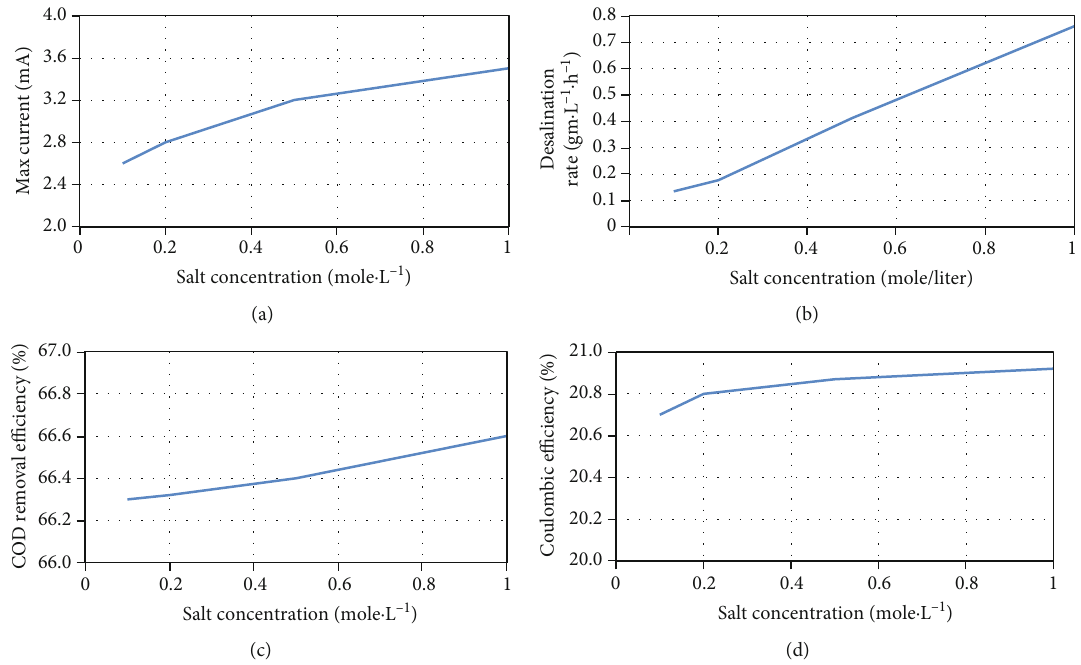
Figure 4: Model predictions in case of changing initial salt concentration on (a) maximum current, (b) desalination rate, (c) COD removal e ffi ciency, and (d) Coulombic e ffi